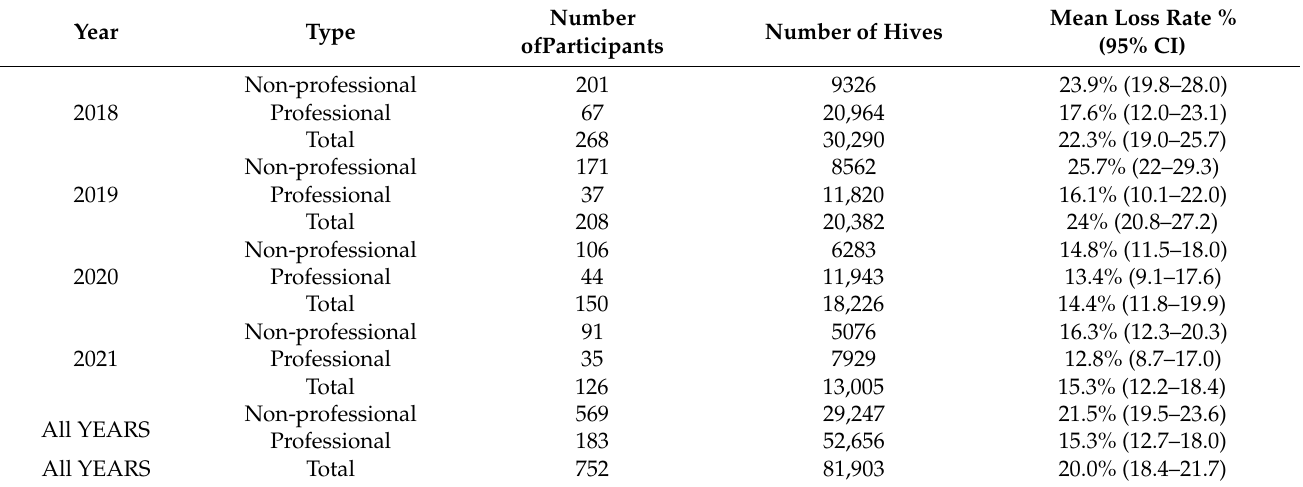
Table 1. Summary of participation and hive loss